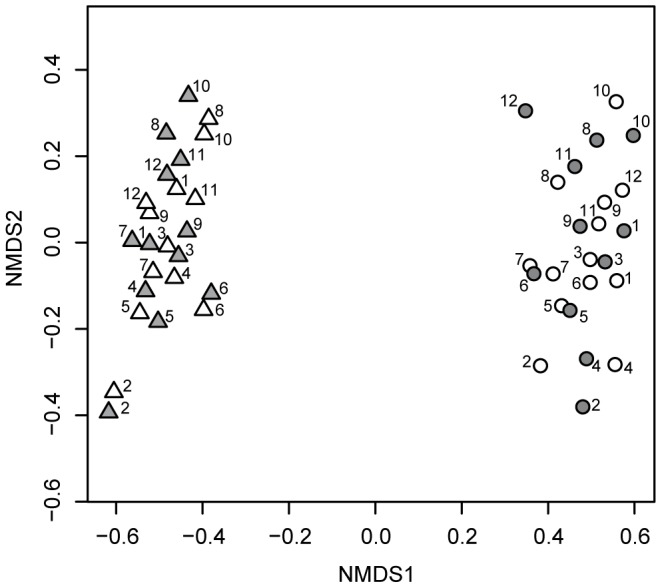
Nonmetric multidimensional scaling based on classified sequences at the genus level.Symbols represent each of the time points corresponding to V1–V3 region (▵) and to V4 region (○). Technical replicates are represented with the same symbols, but different filling (white and gray). The adjoining numbers identify the samples. Stress  =  0.13.